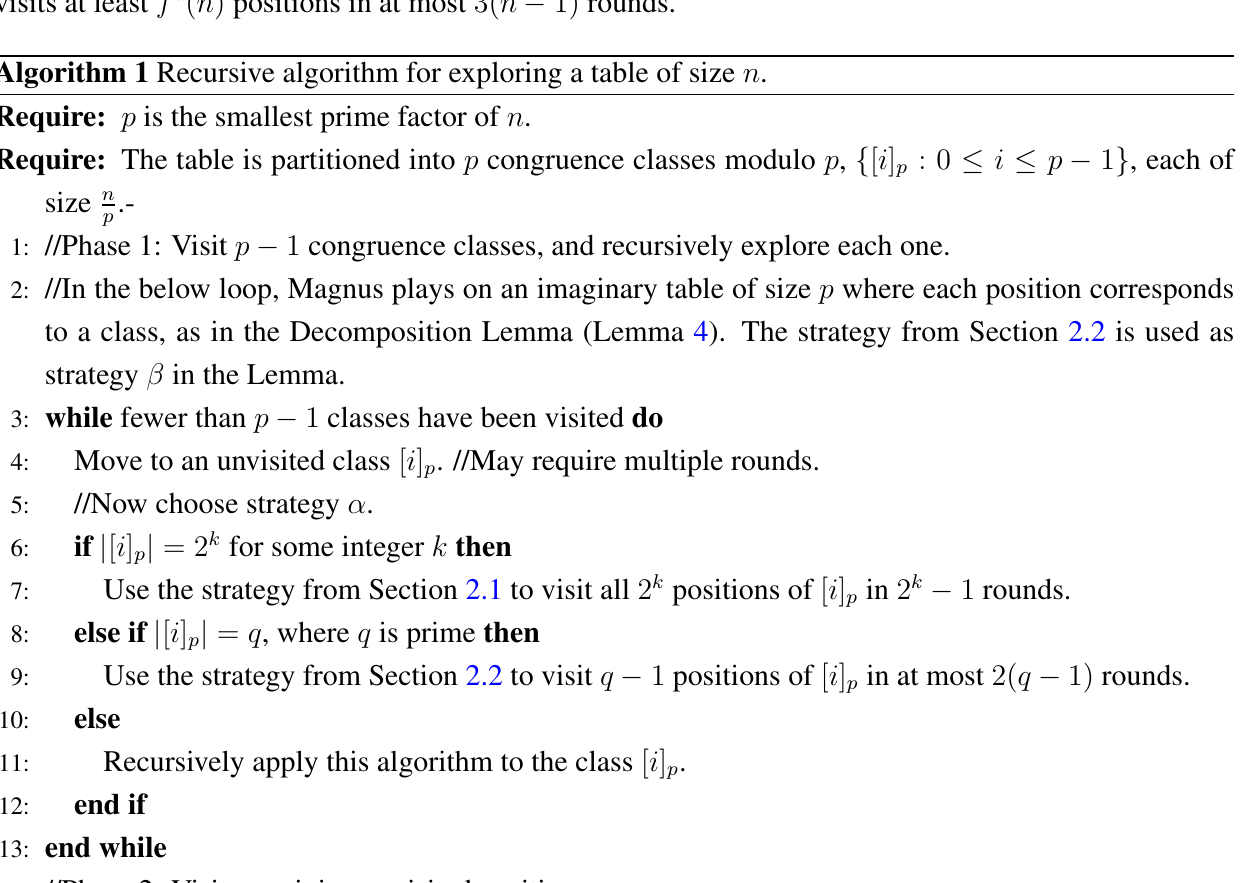
Algorithm 1 Recursive algorithm for exploring a table of size n